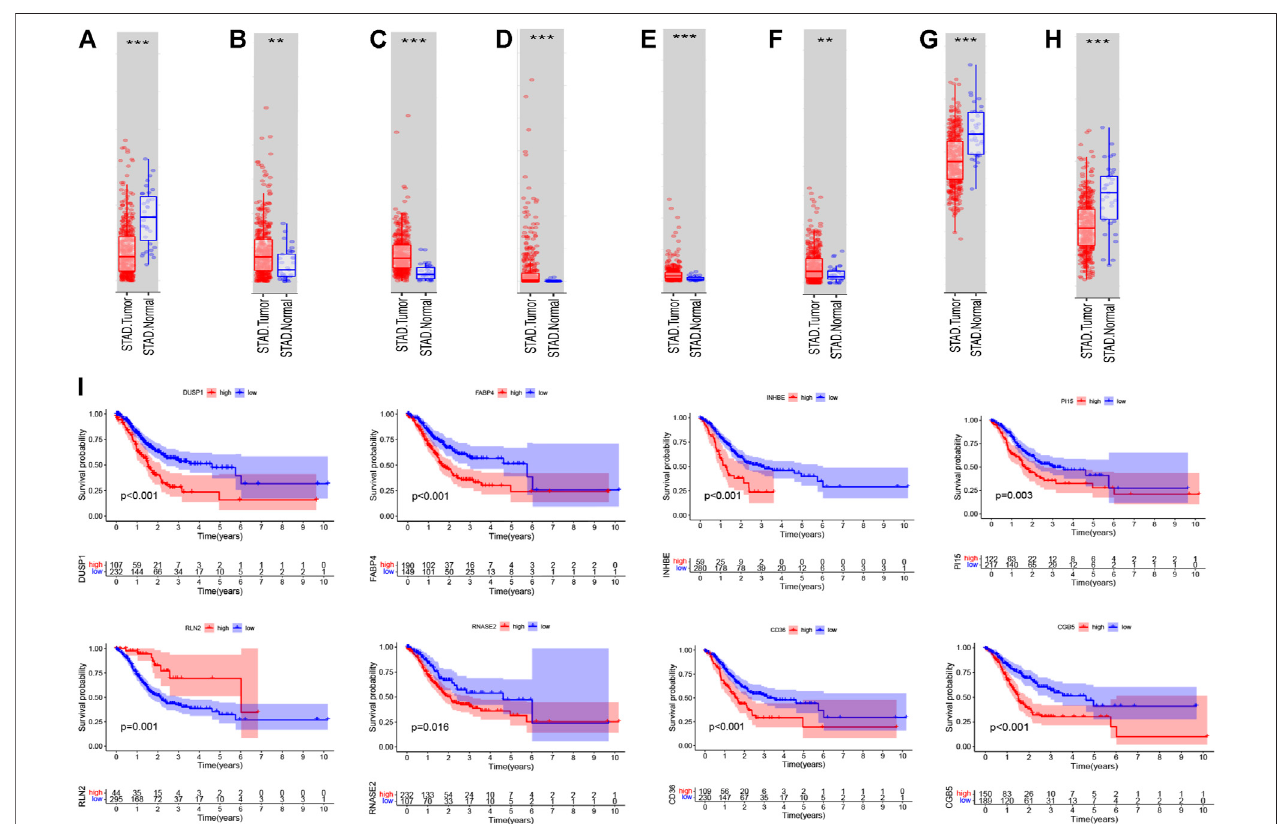
FIGURE 12 | Differential expression; Kaplan – Meier survival curve of all GC patients with the eight immune-related genes. (A – H) Boxplots showing the relative expression levels of FABP4 (A) , PI15 (B) , RNASE2 (C) , CGB5 (D) , INHBE (E) , RLN2 (F) , DUSP1 (G) , and CD36 (H) in normal tissues and GC tissues. *** p < 0.001 and ** p < 0.01. (I) SurvivalcurvesofGCpatientswithhighexpressionandlowexpression ofthefollowinggenes:FABP4,PI15,RNASE2,CGB5,INHBE,RLN2,DUSP1,and